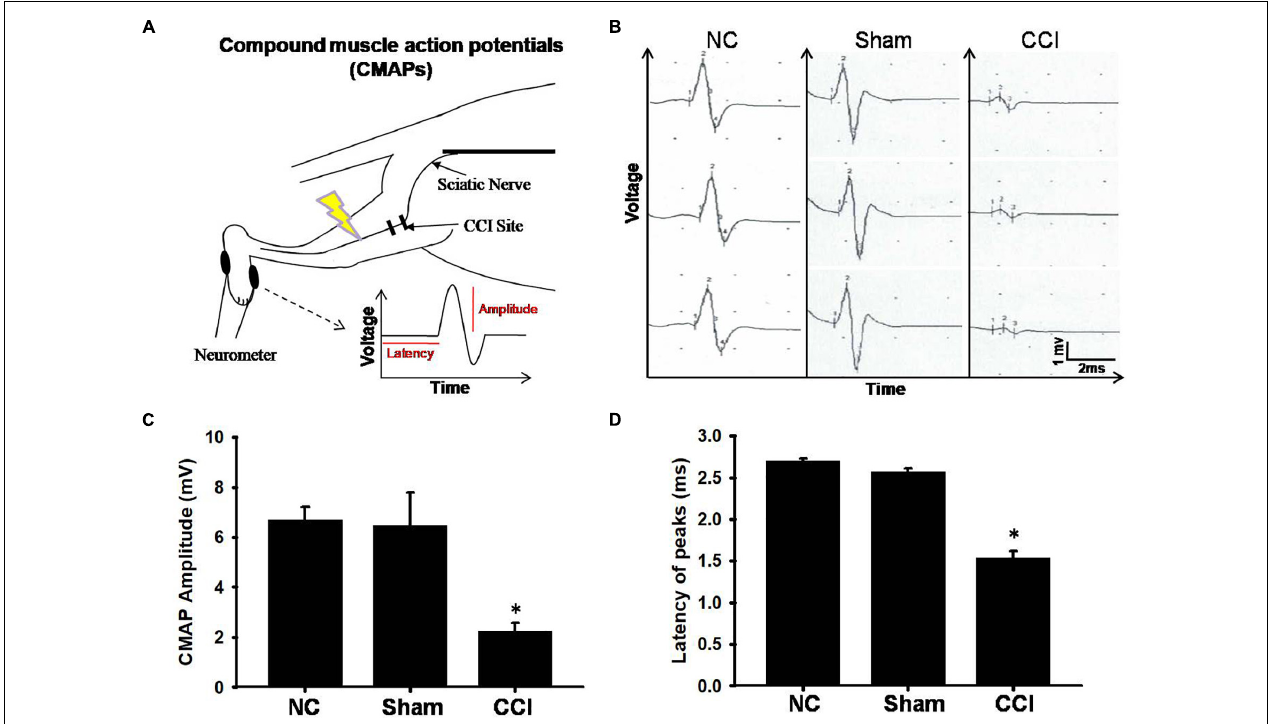
FIGURE 2 | Electrophysiological findings for each group. (A) The schematic of electrode positions for electrophysiological recording neurometer segments of the digital nerve with respect to stimulation. (B) Representative spontaneous voltage recorded from involved plantar muscles from different groups. The scale bars represent 1 mV and 2 ms. (C) Amplitude and (D) latency of compound muscle action potential (CMAP). The vertical dash lines indicate the latencies for the marked amplitude (mV). The horizontal dash lines denote the latency time (ms) of activity in stimuli interval. Data were analyzed by one-way ANOVA with post hoc Dunnett’s test. ∗ p < 0.001 was considered significant as compared with the sham group, n =